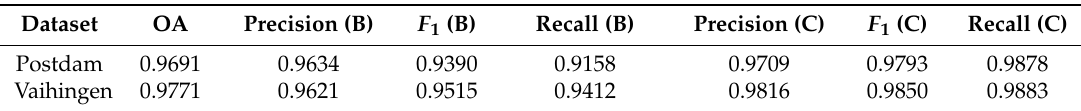
Table 1. Measures the average accuracy for the classification, precision, recall as well as F 1 score for buildings and clutter in Potsdam and Vaihingen, respectively.